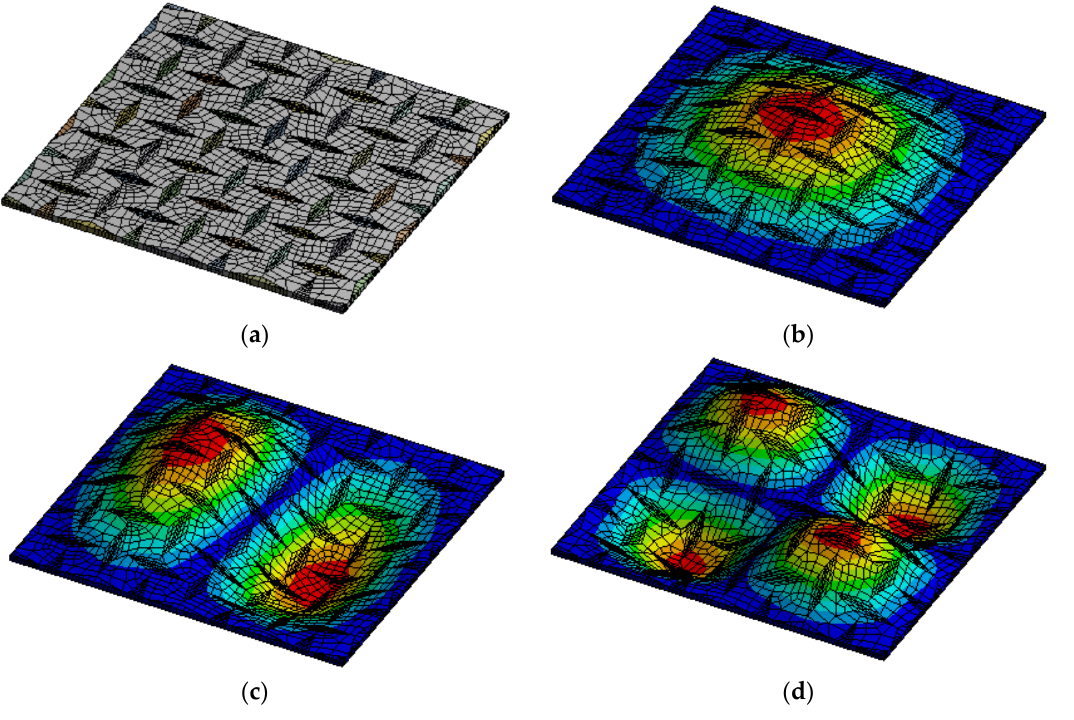
Figure 8. Mode shapes of vibration of the architected plate with clamped boundary conditions obtained by finite element analysis. ( a ) The undeformed plate; the ( b ) first, ( c ) second, and ( d ) third mode of vibration.